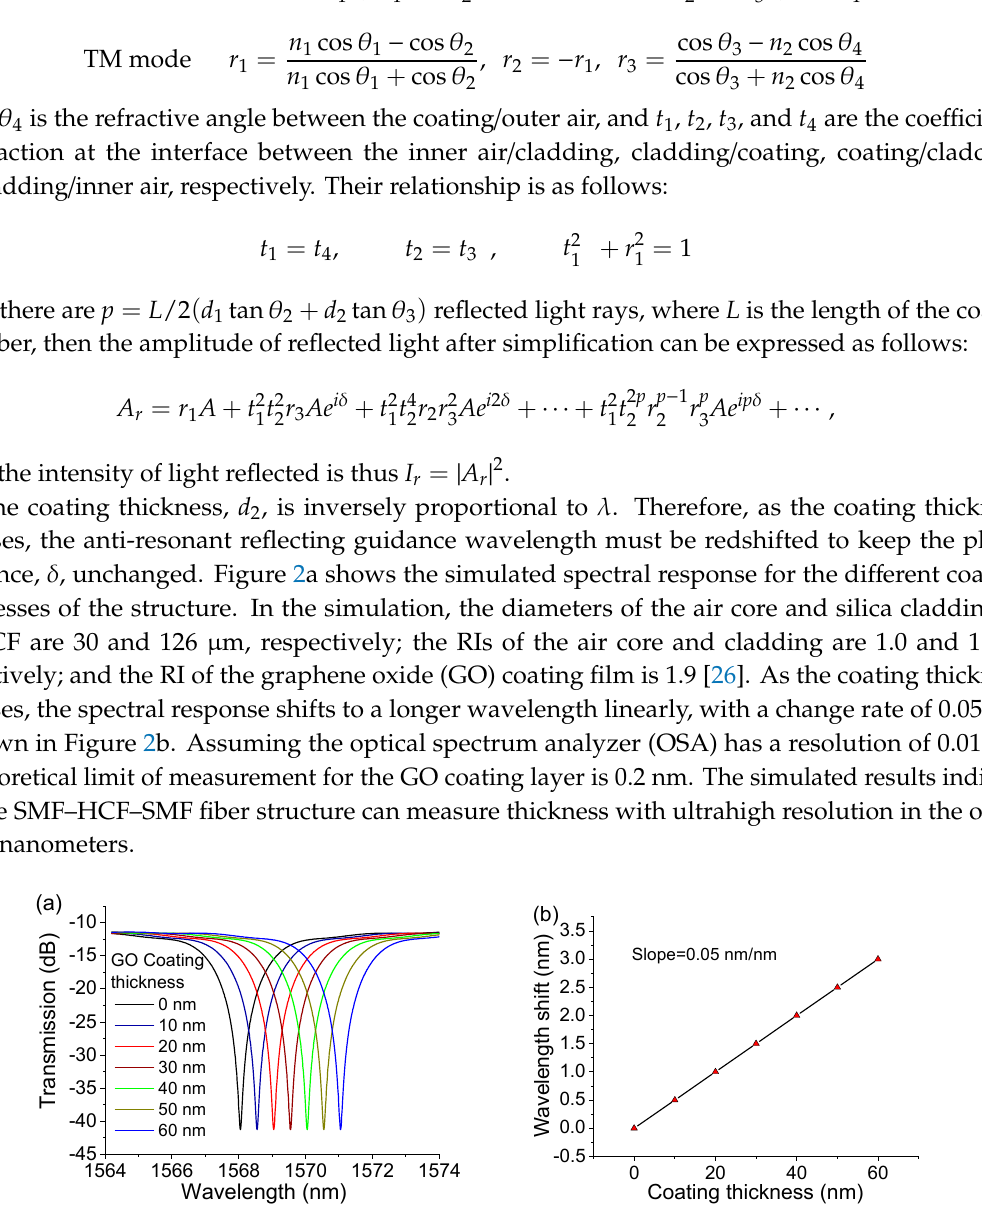
Figure 2. Simulated ( a ) spectral responses and ( b ) wavelength shift of the SMS–HCF–SMS fiber structure at different coating thicknesses.